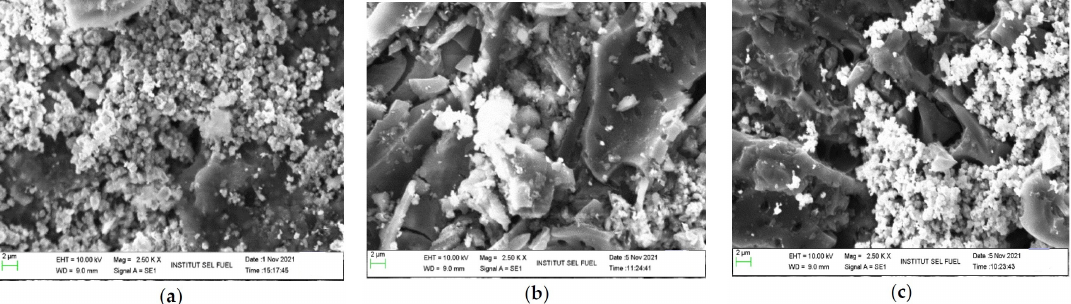
Figure 6. SEM micrograph images for CS/CAC adsorbents at magnification of 2.5 Kx and 2-micron scale: ( a ) ZnAc 2 /ZnO/CAC_WS, ( b ) ZnAc 2 /ZnO/CAC_OS, and ( c ) ZnAc 2 /ZnO/CAC_WOS.